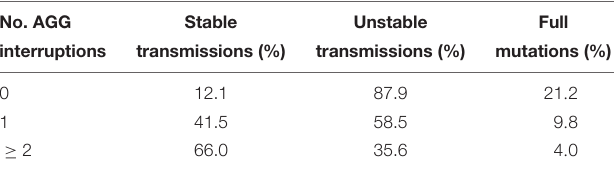
TABLE 2 | The risk of unstable transmission and full mutation expansion according to the number of AGG interruptions among Israeli’s FMR1 premutation carriers with 55–90 CGG